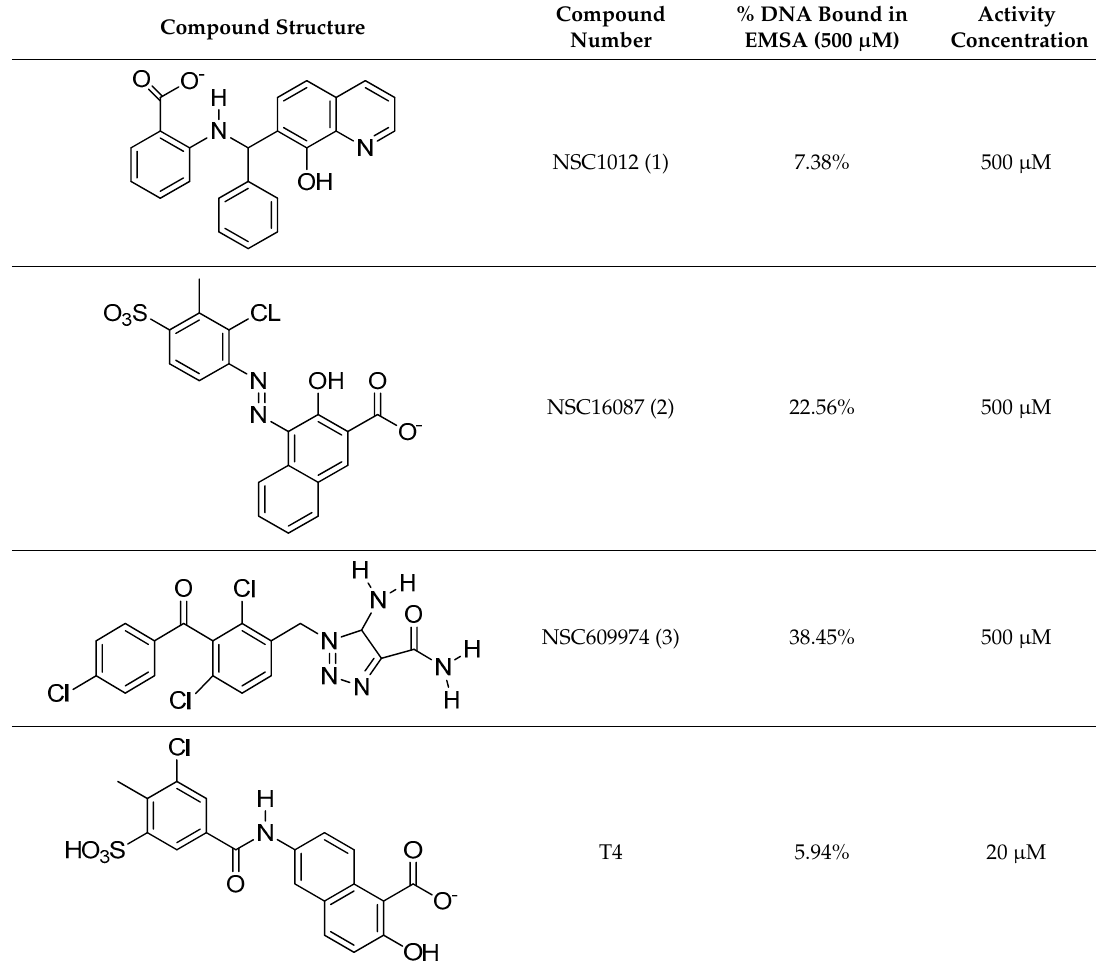
Table 2. Summary of the compounds used and their activity.